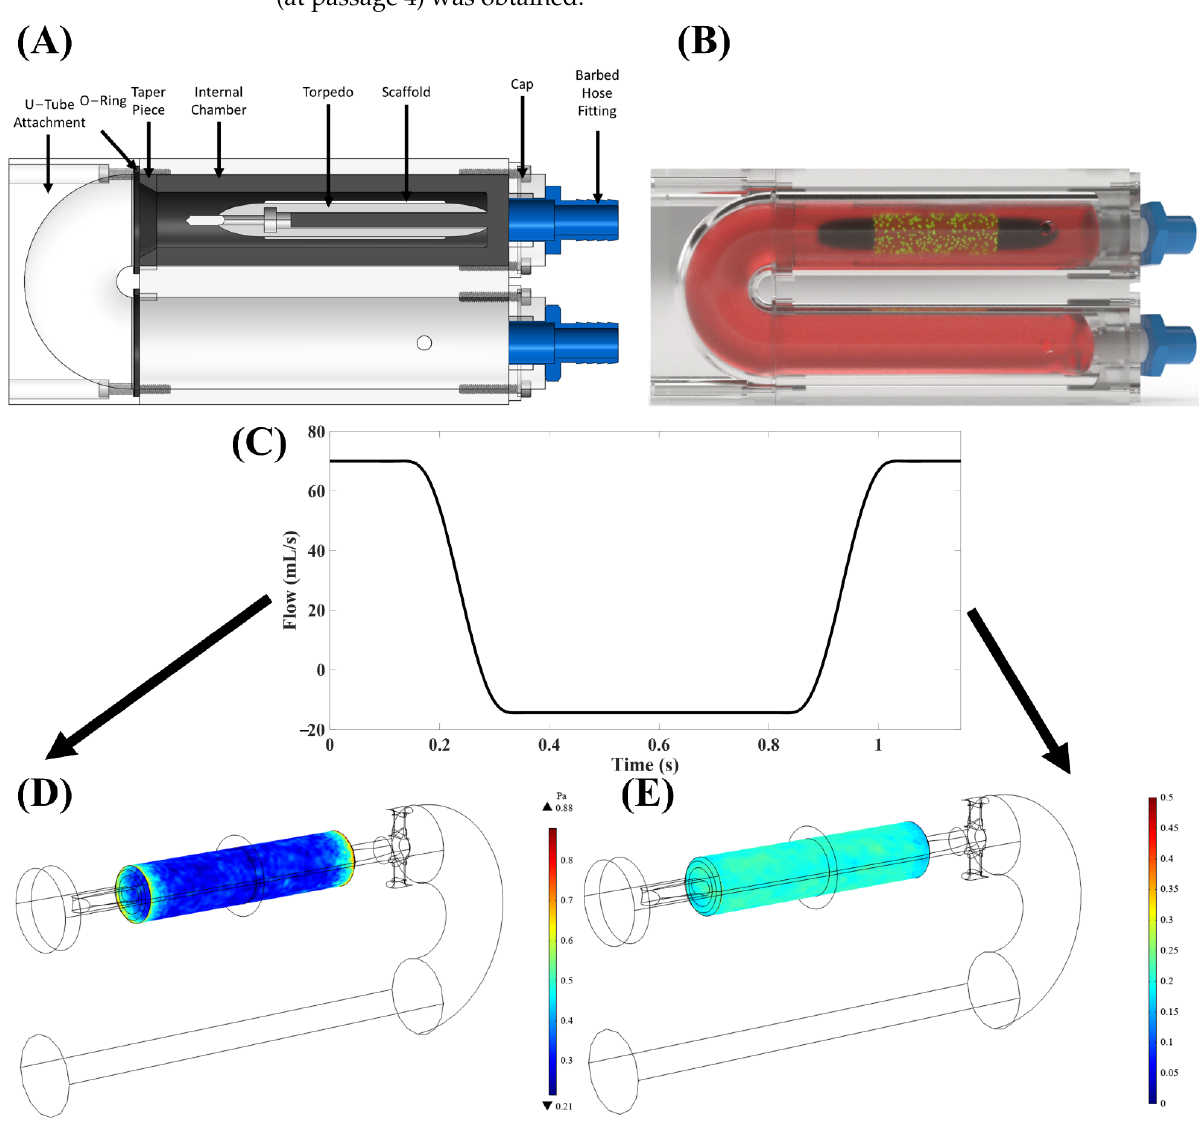
Figure 1. Developed in-house “torpedo” bioreactor with computational fluid dynamics (CFD; AN- SYS Workbench, ANSYS Inc., Canonsburg, PA, USA). ( A ) A design of our bioreactor with the major parts, including the torpedo and tube inlet and outlet. ( B ) Bioreactor schematic filled with cell culture media, the torpedo, and a bio-scaffold on the torpedo with seeded human stem cells repre- sented by the green dots. ( C ) A square waveform was used with a 17% forward and 83% backward flow. This waveform provided a specimen ( D ) time-averaged wall shear stress (TAWSS) of 3.1 dynes/cm 2 and an ( E ) OSI of ~0.20.